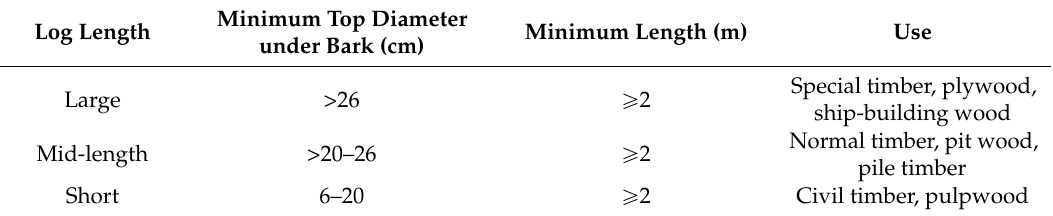
Table 2. Poplar merchantable volume specifications.